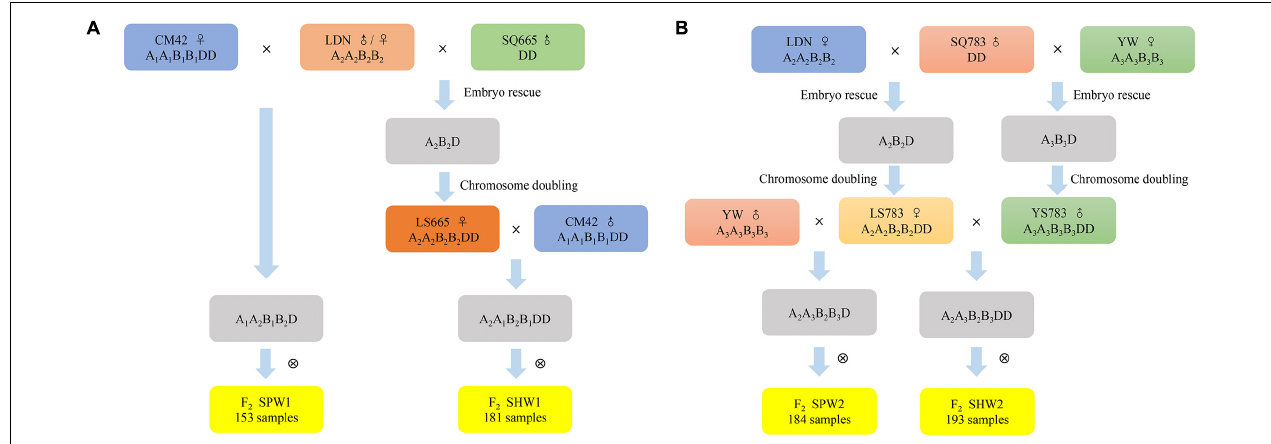
FIGURE 1 | Procedures followed to create mapping populations. (A) CM42 and LS665 were used as the maternal donor to generate SPW1 and SHW1 populations, respectively. (B) LS783 was used as the maternal donor to generate SPW2 and SHW2 populations.